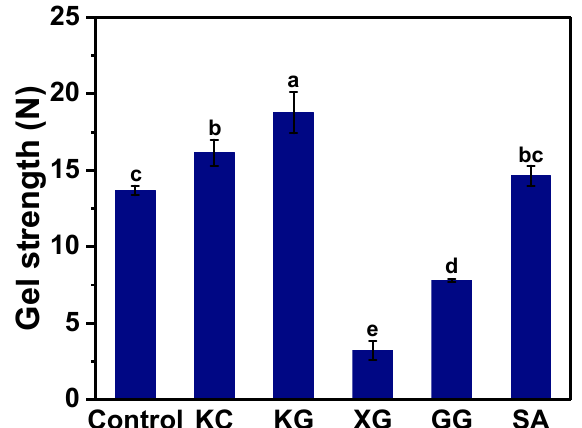
Figure 6. Gel strength of printed cylindrical surimi with different polysaccharides after cooking. KC: κ -carrageenan; KG: konjac gum; XG: xanthan gum; GG: guar gum; SA: sodium alginate. Bars indicate the standard deviation (n = 5). Lowercase letters on the bars indicate significant differences ( p < 0.05).